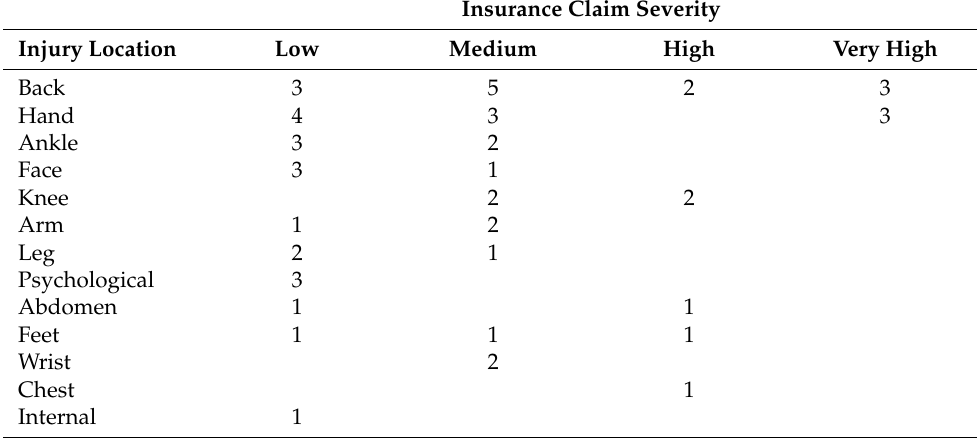
Table 5. Injury severity and location.